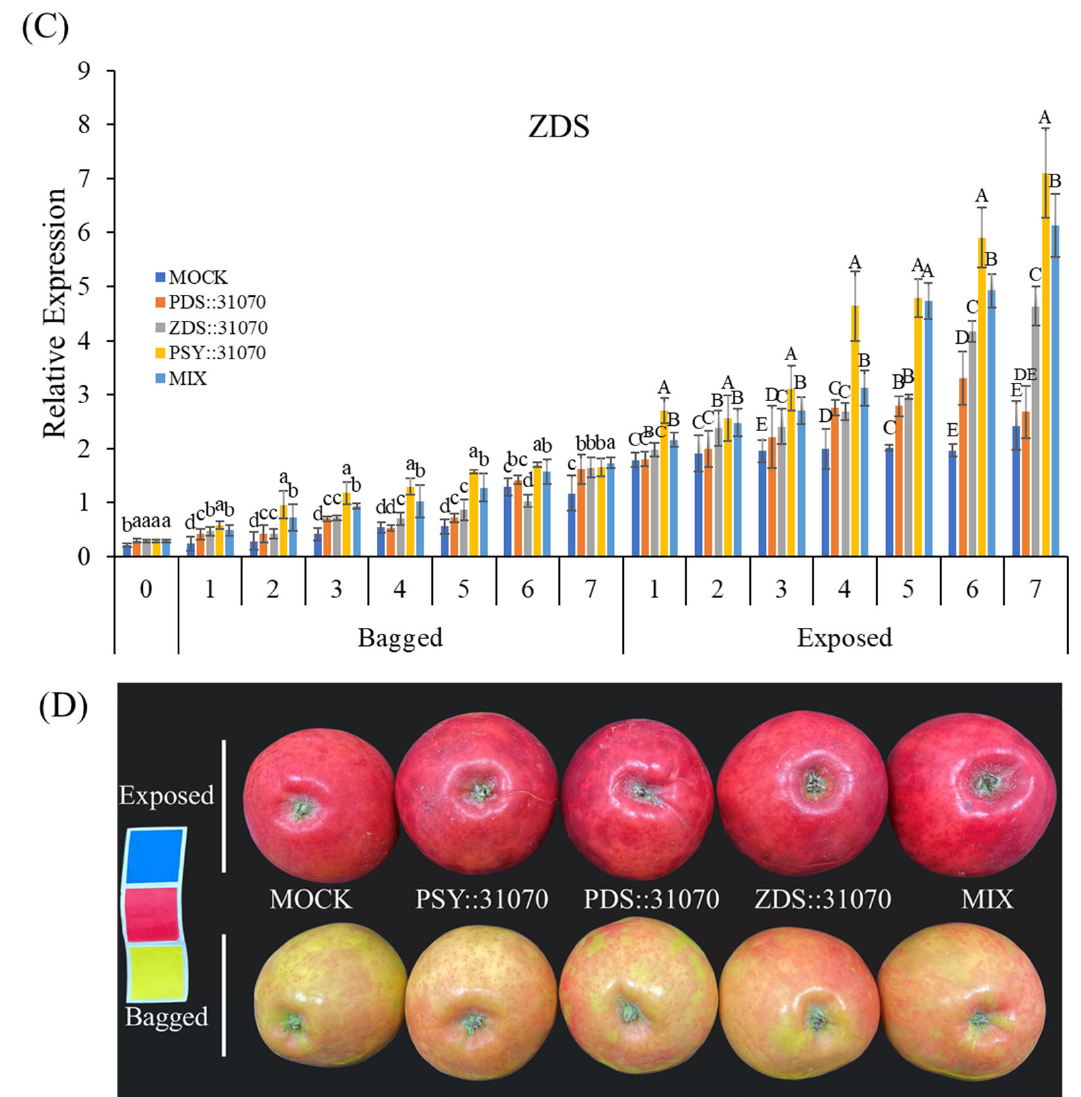
Figure 7. Expression profiles of carotenoid biosynthesis-related genes PSY ( A ), PDS ( B ), and ZDS ( C ) in darkness (bagged) and after light exposure (exposed) for the ‘RubyS’ apple fruit skin after Agro ‐ vacuum infiltration. Agroinfiltrated fruits at 7dpi ( D ). MOCK fruits were Agro ‐ vacuum infil ‐ trated with an empty vector; PSY::31070, PDS::31070, and ZDS::31070 fruits were Agro ‐ vacuum in ‐ filtrated with a single expression vector, respectively; MIX fruits were Agro ‐ vacuum infiltrated with a mixture of three (PSY::31070, PDS::31070, and ZDS::31070) expression vectors. Different lowercase and uppercase letters represent a significant difference ( p < 0.05) in the bagged and exposed fruits,